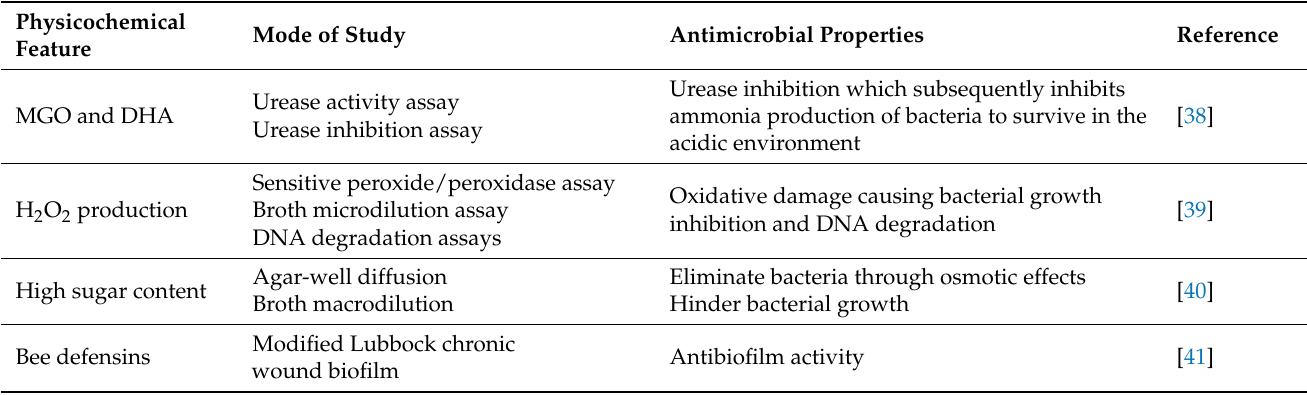
Table 2. Physicochemical features of honey and their antibacterial properties.